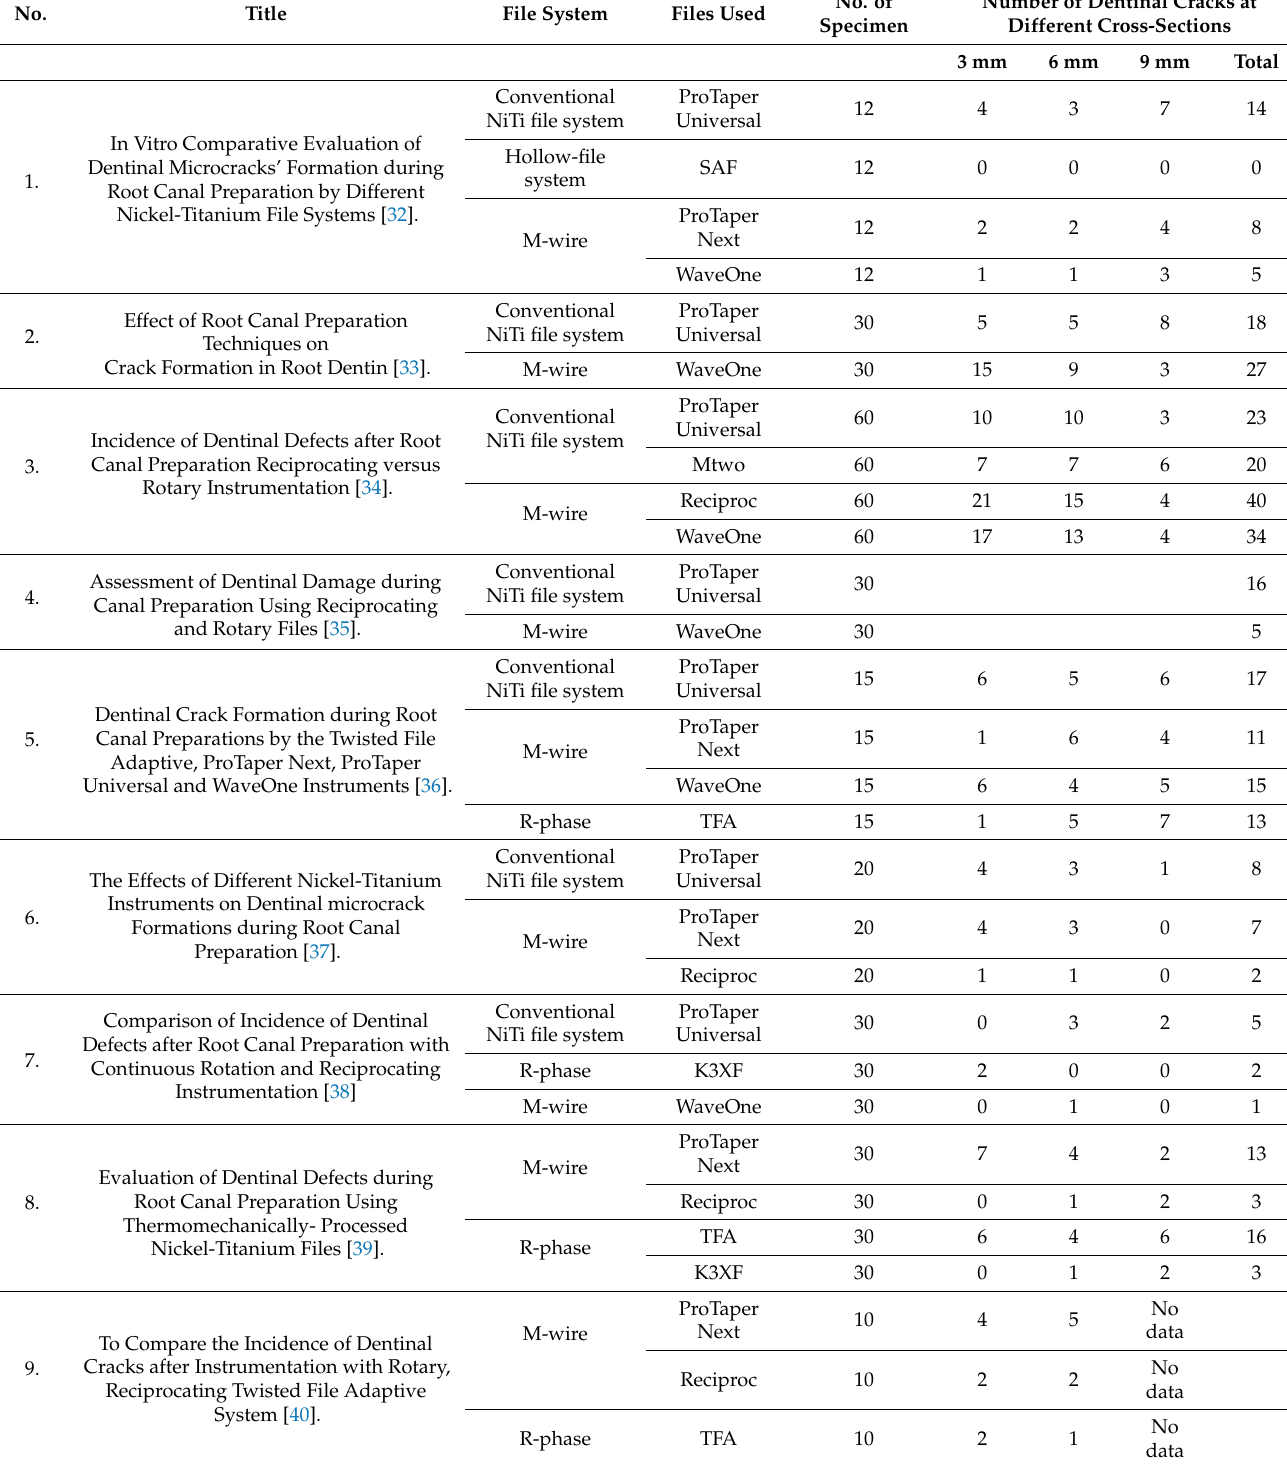
Table 6. Number of dentinal cracks in different